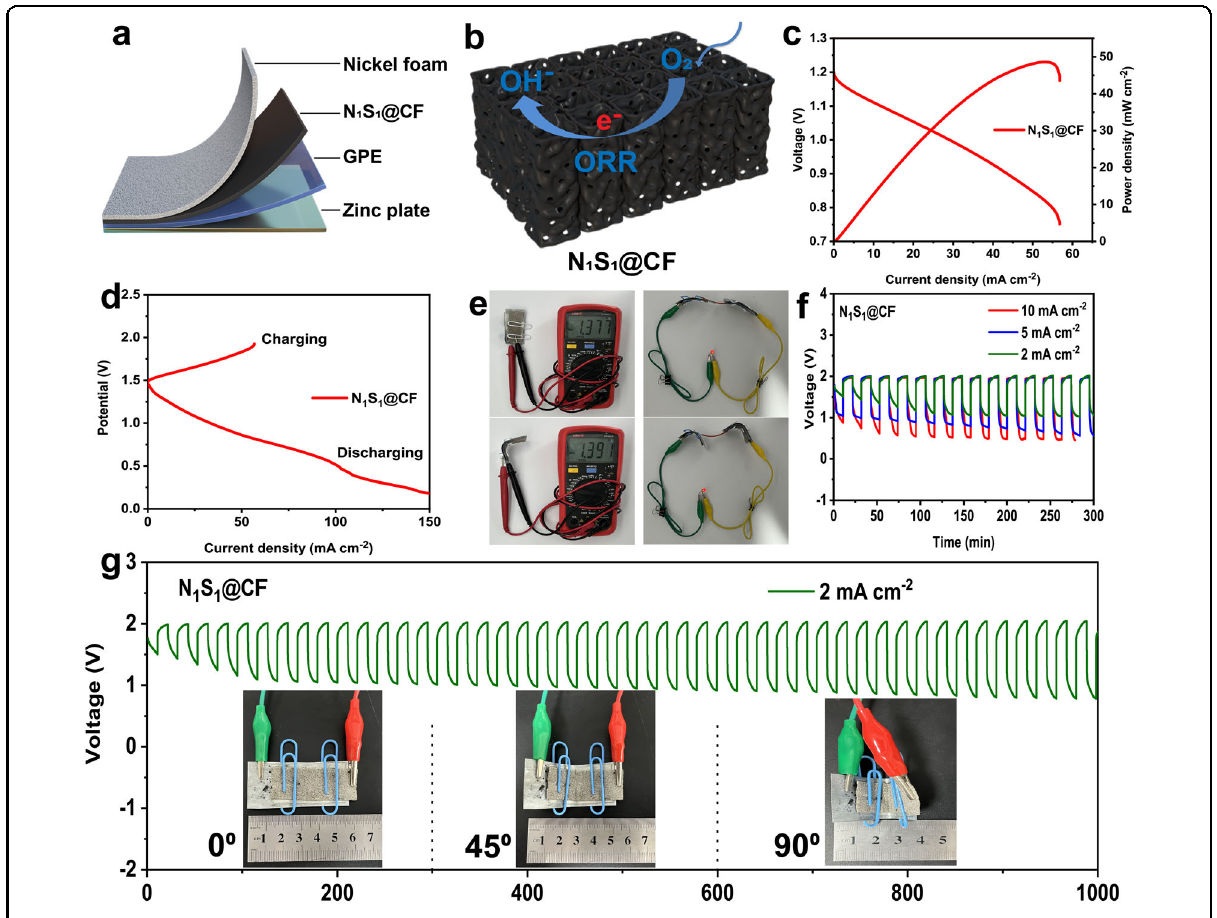
Fig. 5 Characterization of a FZAB. a , b Schematic diagram of a FZAB. c Charge ‒ discharge polarization curve. d Discharge polarization curves and corresponding power densities of FZABs loaded with N 1 S 1 @CF. e Open-circuit current-voltage photograph of a single FZAB and a red LED powered by two series-connected batteries under fl at and bent conditions. f Charge ‒ discharge curves for different current densities. g Charge ‒ discharge cycle curves for FZABs with N 1 S 1 @CF air electrodes under different bending